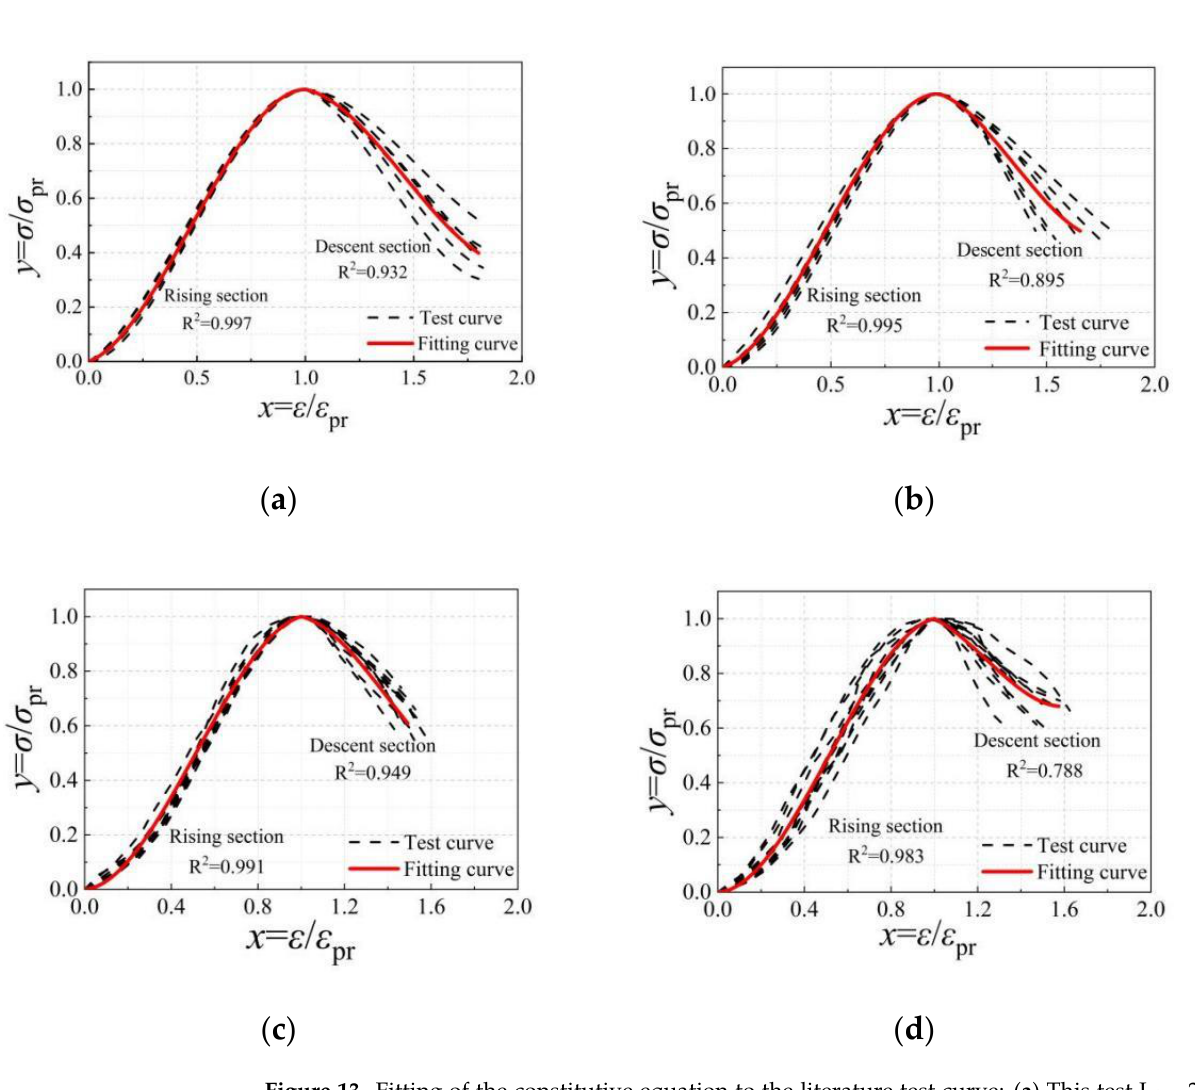
Figure 13. Fitting of the constitutive equation to the literature test curve: ( a ) This test L 100 -28-1.0 (Xinjiang); ( b ) This test L 100 -28-0.2 (Xinjiang); ( c ) [34] L 100 -28-2.0 (Xinjiang); and ( d ) [34] L 100 -28-2.0 (Heilongjiang).